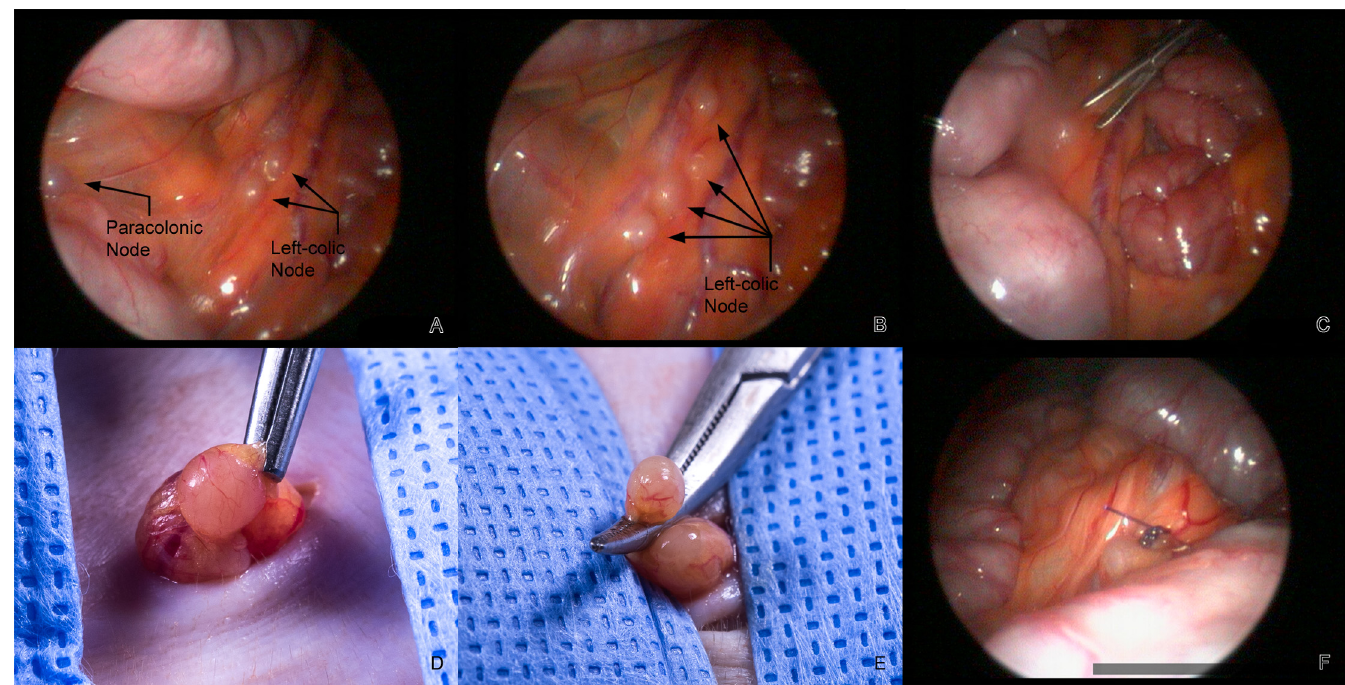
Fig 1. A . Laparoscopic view of a paracolonic and two left-colic nodes draining a portion of the descending colon. B . Four left colic nodes draining a different portion of the descending colon. C . Use of the Maryland forceps to grasp the mesentery adjacent to a left-colic node prior to externalization. D . Externalized node held with a rat tooth forceps. E . Externalized node clamped with a mosquito hemostat prior to ligation. F . 4 – 0 PDS at ligature site in the